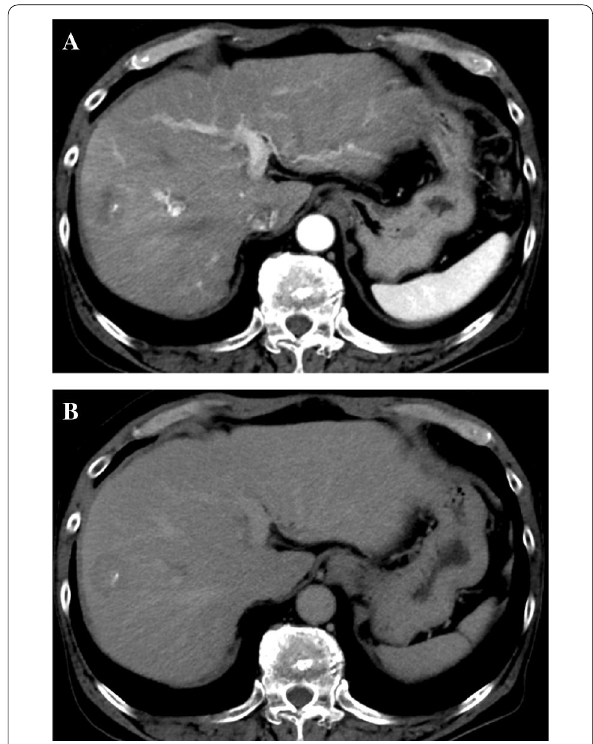
Fig. 2 A , B Abdominal contrast-enhanced computed tomography shows a tumor measuring 23 mm in size with ring enhancement in the early phase (arrow). The tumor shows hypointensity in the delayed phase